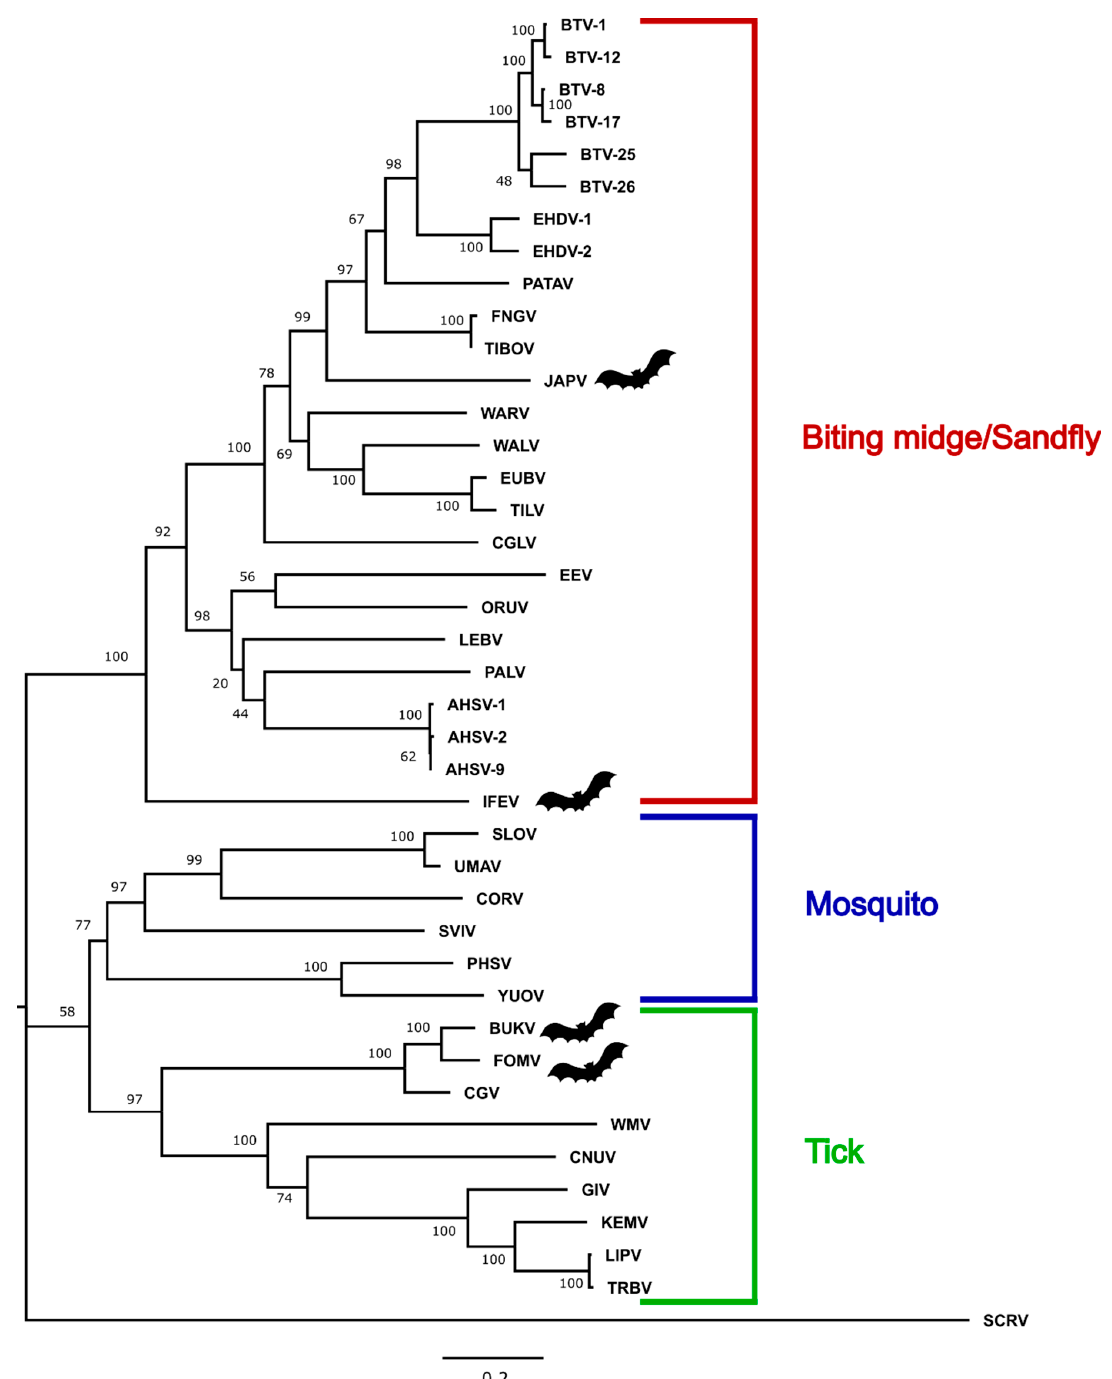
Figure 2. Maximum-likelihood phylogenetic tree of the viral polymerase (VP1) of selected orbiviruses (amino acid) constructed in MEGA7 using 1000 bootstrap replicates. The tree is drawn to scale, with branch lengths measured in number of substitutions per site. The tree was rooted with St. Croix River virus (SCRV). Bat symbols identify the viruses sequenced in this study. Full virus names are provided in the Materials and Methods section and accession numbers are provided in Table S1.